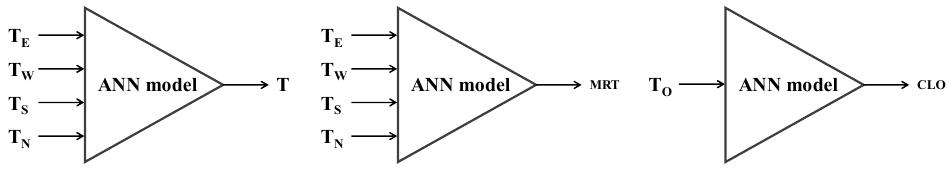
Figure 1. Input/output data set for T (indoor air temperature), MRT (mean radiant temperature) and CLO (Clothing) estimation model.